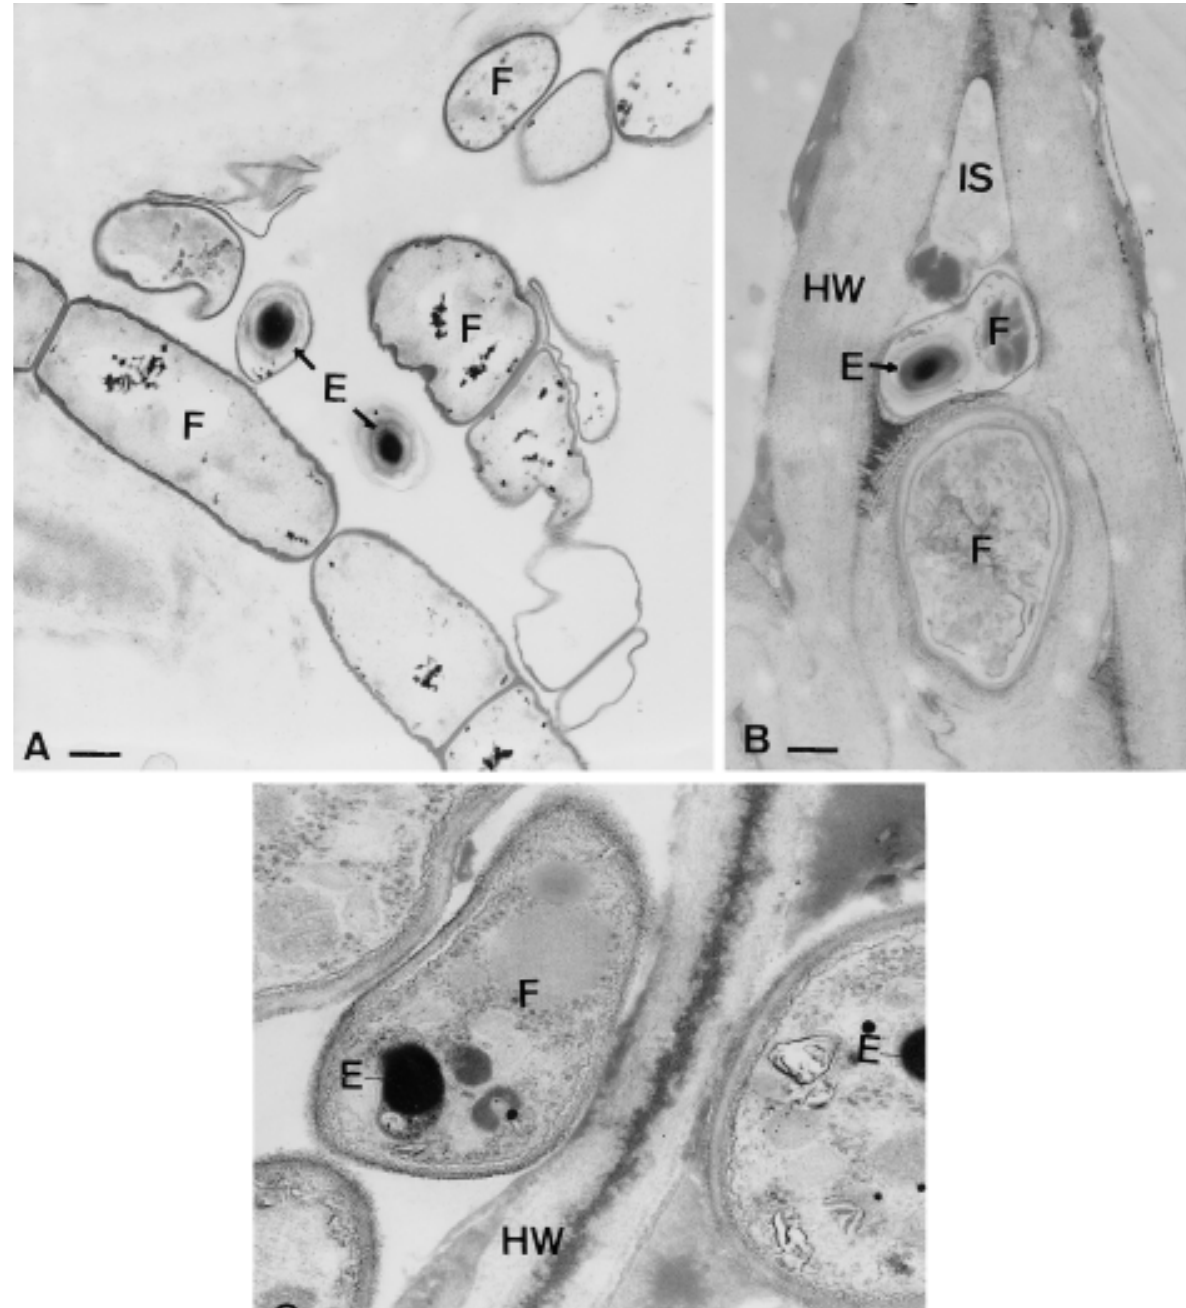
Fig. 3. TEM sections of potato cv. Spunta tissues 7 days after bacterization with Bacillus thuringiensis 55T and challenge with Fusarium roseum var. sambucinum . (A, B, C) Bacterial endospores in potato tissues colonized by the pathogen. Bar = 500 nm. E, endospore; F, fungus; HW, host wall; IS, intercellular